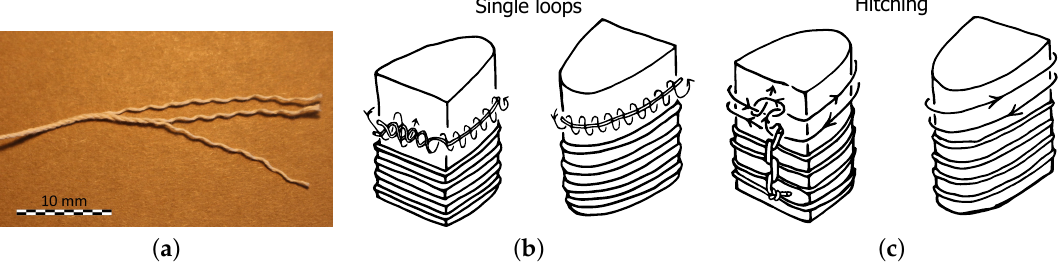
Figure 2. Studied types of fiber reinforcements. ( a ) Structure of the 0.7-mm three-strand cotton thread used for reinforcements; ( b ) Separate single loops had a single strand of the thread wound around itself twice. It was locked in place by tying the strand’s ends together with a small knot; ( c ) Two-directional hitching was made by tying consecutive left and right half-hitches with the three-strand thread around the actuator. The first and last loop were locked in place with a reef knot or a hitch. The combined reinforcement layout was made by placing both single loops and hitching on the actuator in series. Illustrations courtesy of Kouki Shiota.